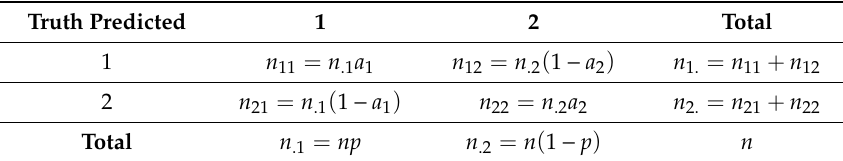
Table 2. Confusion matrix populated with formulae for solving for standard error rates expected under varying map accuracy scenarios.